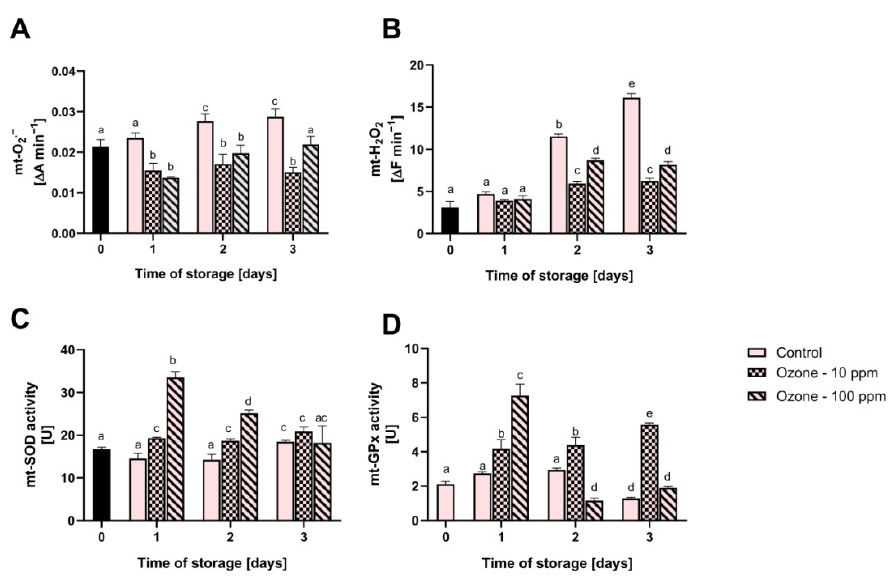
Figure 4. Effect of ozone treatment on the generation of mitochondrial superoxide radical anion ( A ) and hydrogen peroxide ( B ) as well as the activity of mitochondrial superoxide dismutase ( C ) and glutathione peroxidase ( D ) in fruit during storage. Mean values with standard deviations (error bars), with the same lower case are not statistically significant according to the t-Tukey test ( α = 0.05).